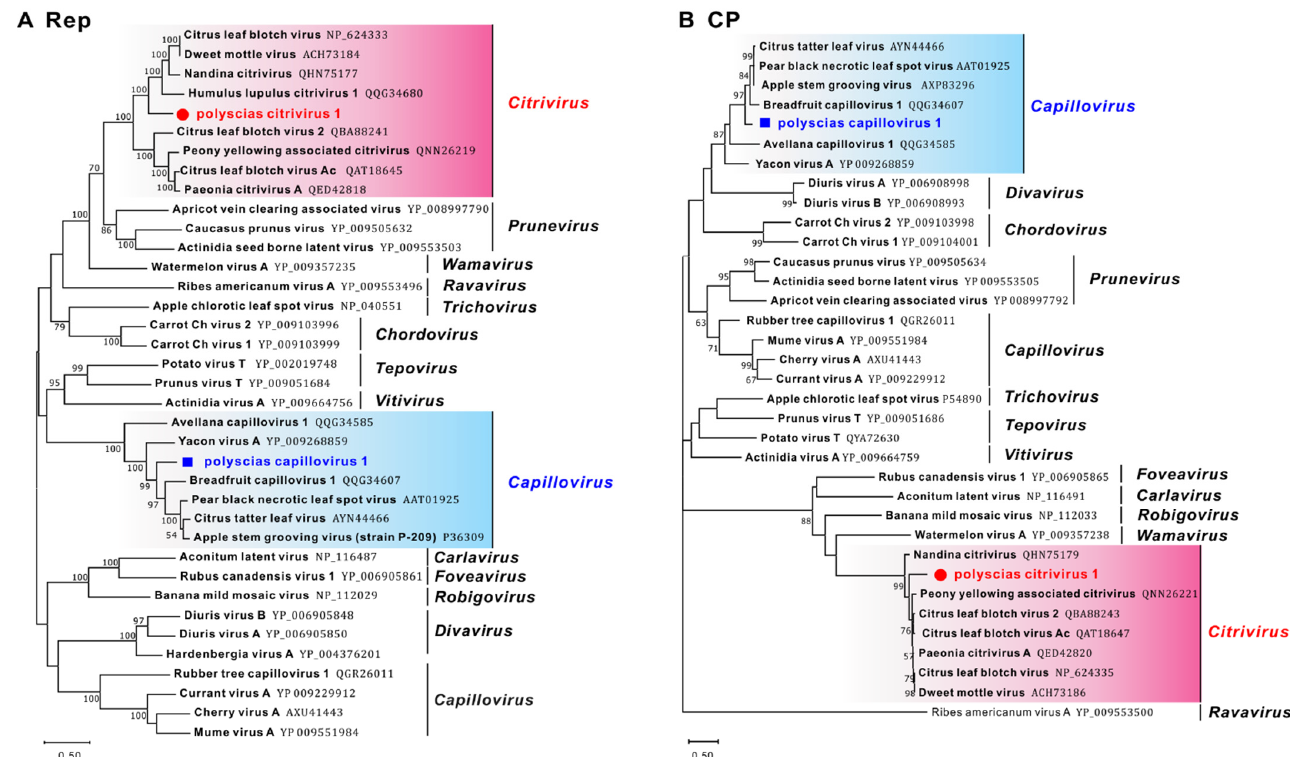
Figure 2. Phylogenetic trees constructed on the basis of ( A ) Rep and ( B ) CP amino acid (aa) sequences of representative members of the Betaflexiviridae family. The trees were constructed using the neighbour-joining method, and the statistical significance of branches was evaluated by bootstrap analysis (1000 replicates). Bootstrap values above 50% are shown. Scale bar represents 50% aa sequence divergence. Newly discovered viruses are indicated by red circles (polyscias citrivirus 1, PCrV-1) and blue squares (polyscias capillovirus 1, PCaV-1). Genera are indicated on the right. Capillovirus genus (containing PCaV-1), pink background; Citrivirus , blue background.